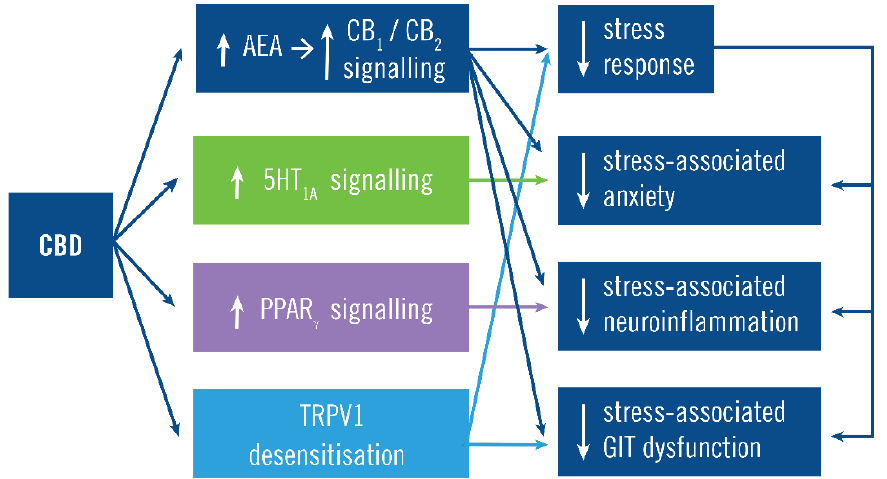
Figure 3. Cannabidiol (CBD) mechanism of action. The main action of CBD is to increase CB 1 and CB 2 signaling by preventing N ‐ arachidonylethanolamine (AEA) degradation. This constrains the stress response and its manifestations both via its inhibition of the stress response and (independently) inhibition of some manifestations such as the anxiety, neuroinflammation, and GIT dysfunction. For example, CB 1 signaling inhibits stress ‐ associated anxiety by both constraining the stress response and by CB 1 activity on forebrain glutamatergic neurons [41 – 43]. CBD also acts independently of CB 1 /CB 2 signaling by increasing serotonergic 5HT 1A signaling, increasing PPAR γ signaling and desensitizing TPRV1, which inhibit stress ‐ associated anxiety, neuroinflammation and GIT dysfunction, respectively.